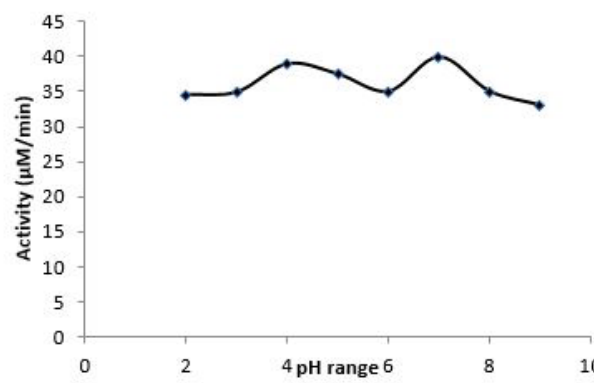
Figure 4: Effect of pH on C. lanatus rind invertase activity.